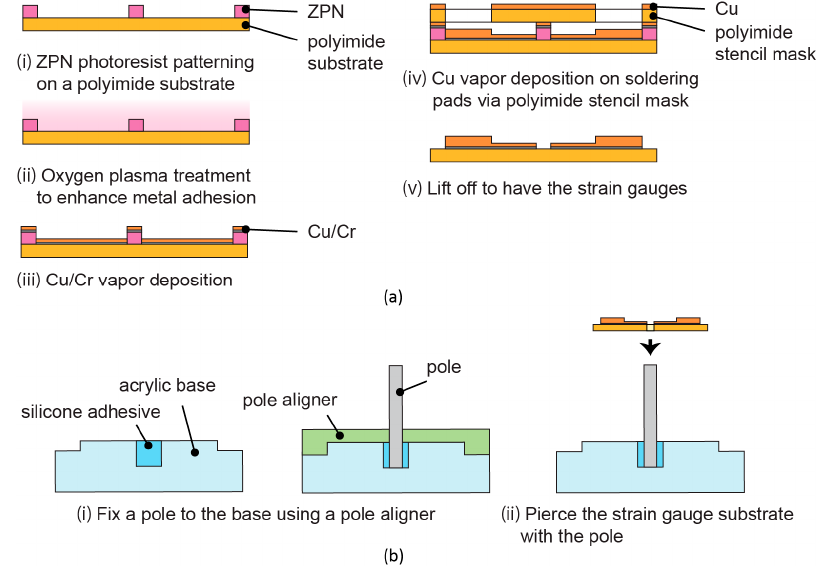
Figure 3. Fabrication process of the device. ( a ) Lift-off process for the making of the strain gauges on polyimide film and ( b ) the assembly process of the base, pole, and strain gauge.